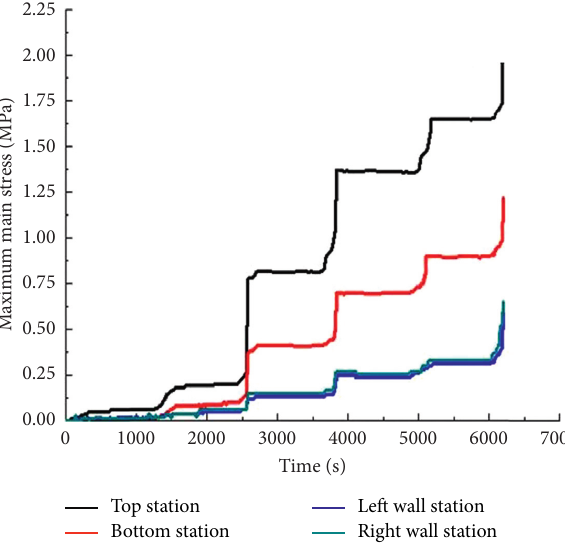
Figure 20: Load-displacement curve at top of supported model.